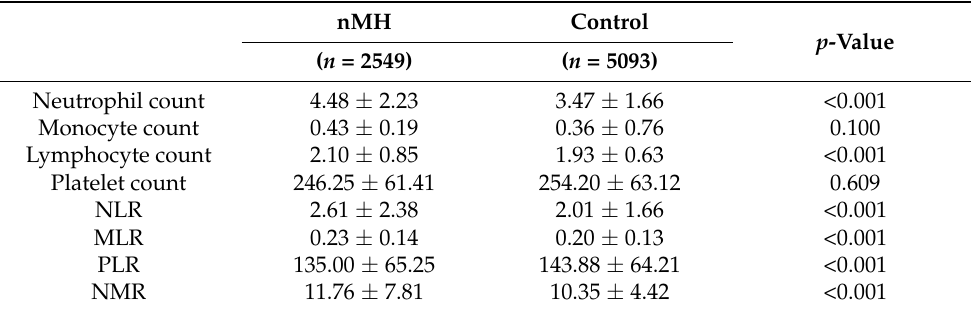
Table 5. Peripheral inflammatory markers of the non-migraine headache and control groups af- ter PSM.